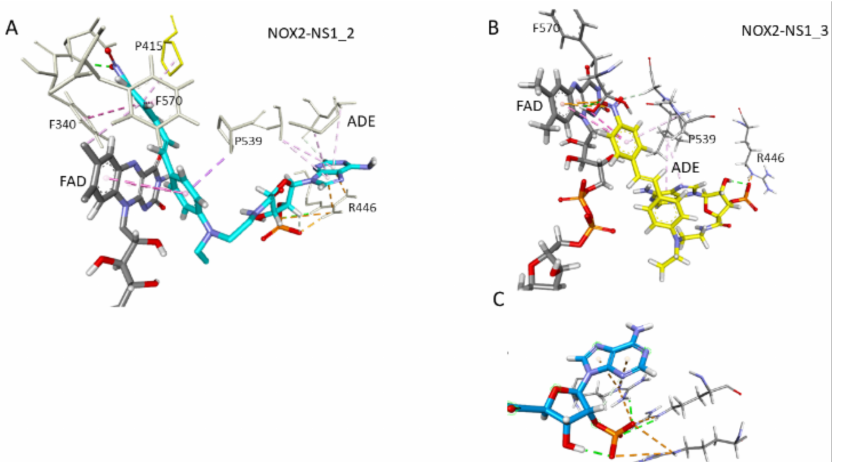
Figure 8. Comparison of the binding of NS1-2 ( A , shown in cyan) and NS1-3 ( B , shown in yellow) to a model of NOX2. For clarity, only FAD, and residues involved in the ligands binding are shown. ADE stands for adenine. ( C ) Zoom-in of the phosphate interaction with lysine/arginine residues, driving the recognition of NOS and